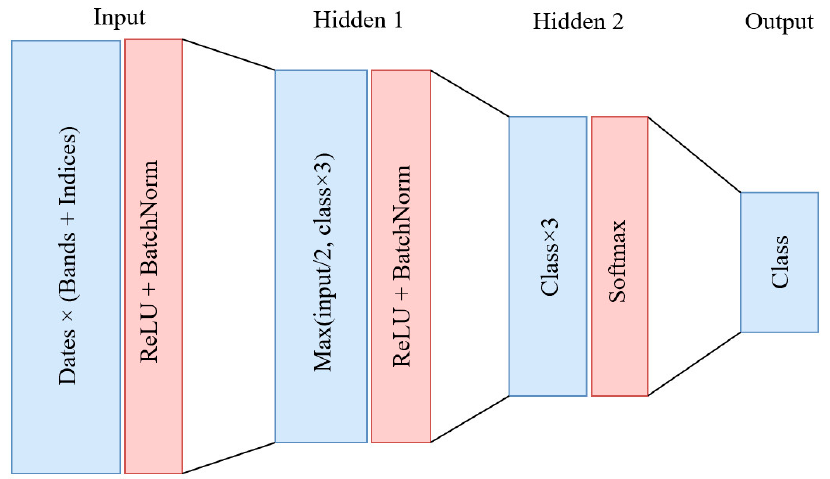
Figure 4. The architecture of Multi-Layer Perceptron (MLP) in this study.